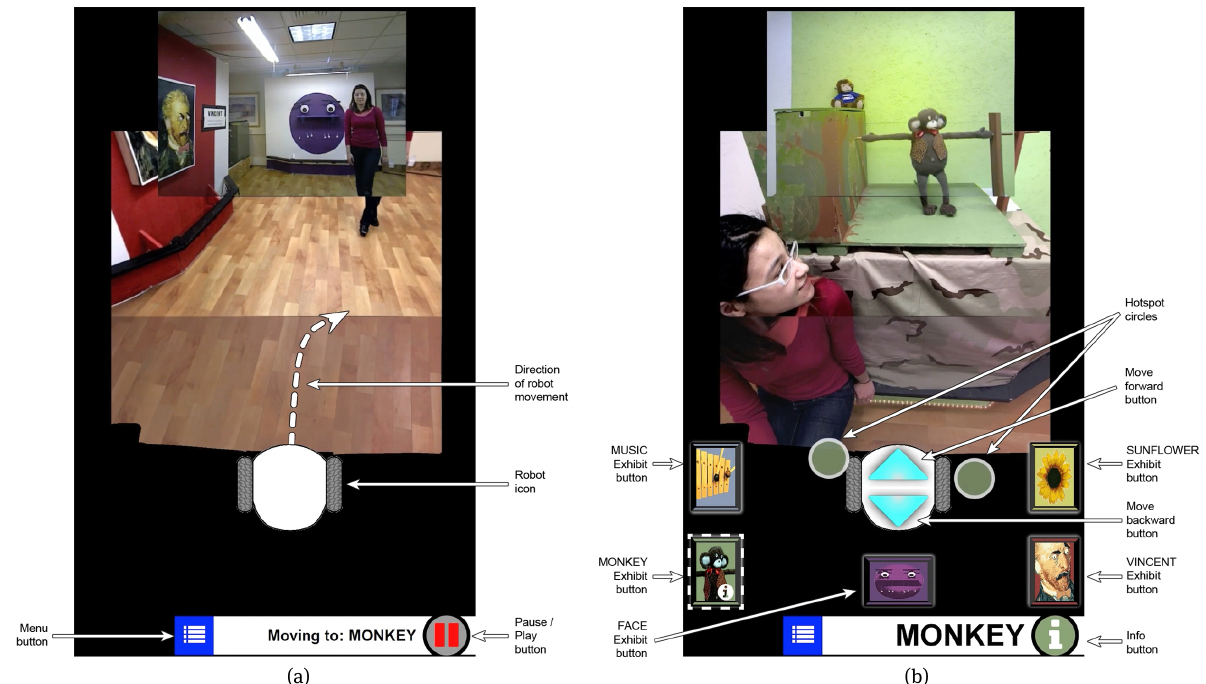
Fig. 8. Our augmented reality graphical user interface design for visiting an art gallery via a telepresence robot. (a) To scale robot base icon overlaid on the bottom of the robot’s video stream; the animated vector indicator (AVI, white dotted arrow) shows the robot’s direc- tion of travel towards selected exhibit. (b) Once at the selected exhibit, exhibit buttons are shown around the robot base icon, providing the user with high-level control over the robot’s movement. Four hotspots can be overlaid on the robot’s video stream indicate alternative view points to see the exhibit from the left , center , right and the exhibit information info via the far right hotspot. In this image, the robot is located at the center hotspot of the Monkey exhibit; adjacent left and right hotspots appear on either side of the robot base icon. Addition- ally, the forward/reverse step buttons (i.e., two cyan triangle buttons) appear overlaid on robot base icon, providing low-level control.